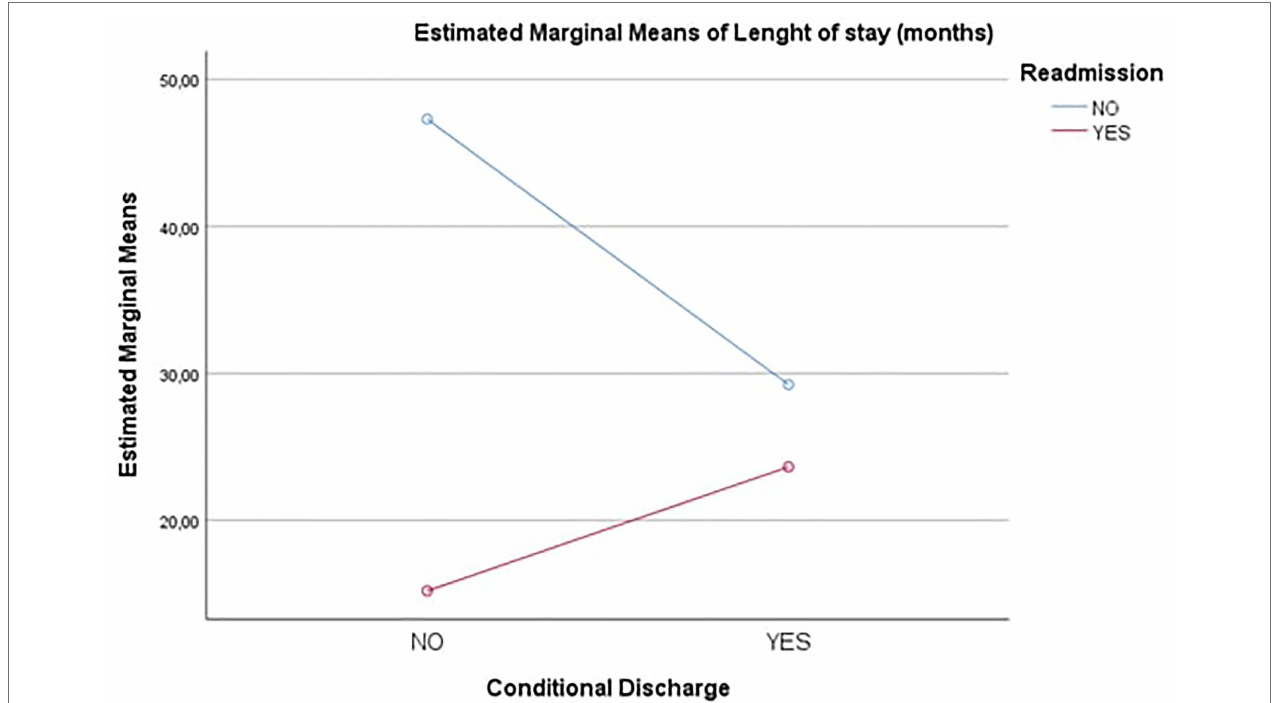
FIGURE 2 | Estimated marginal means – Length of stay (months). Conditional Discharge = Conditional